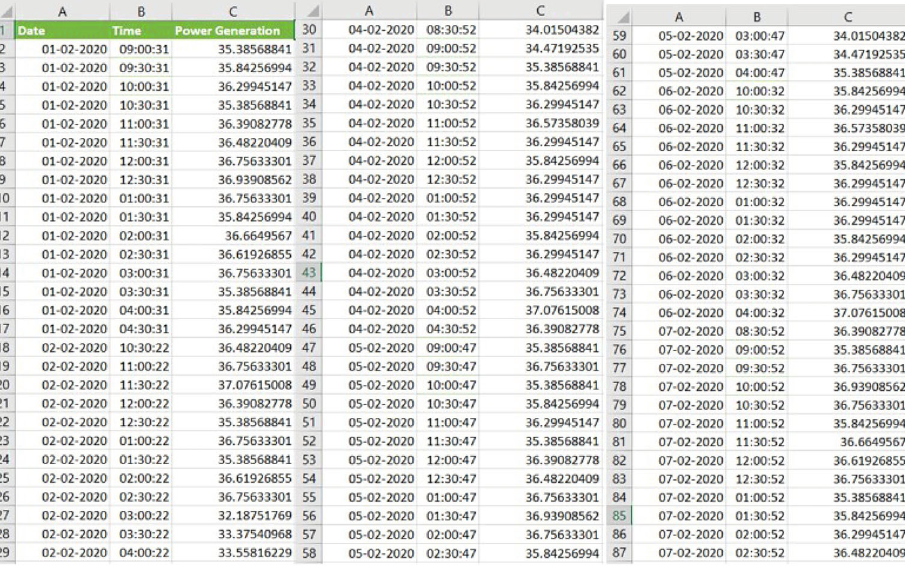
Figure 11: Power generation of 40 W PV